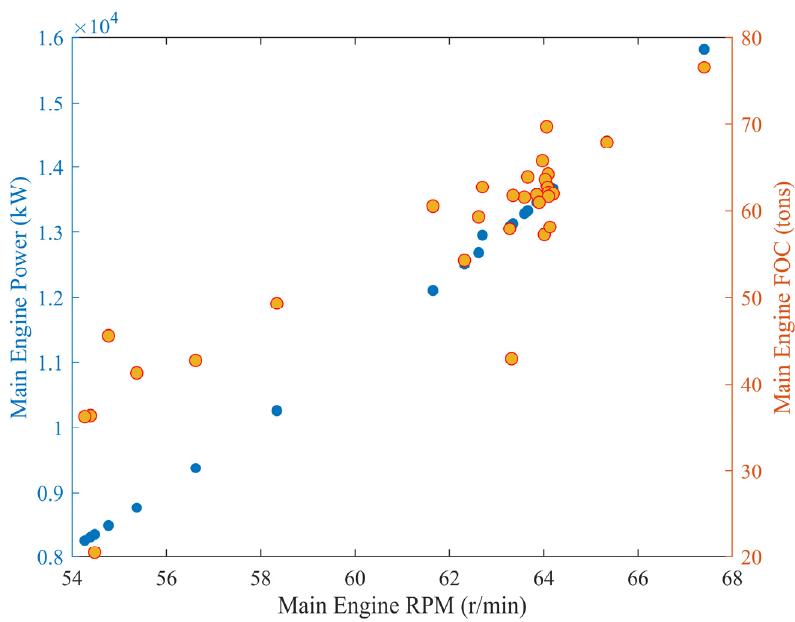
Figure 8. Noon report data of a VLCC’s voyage in 2019.